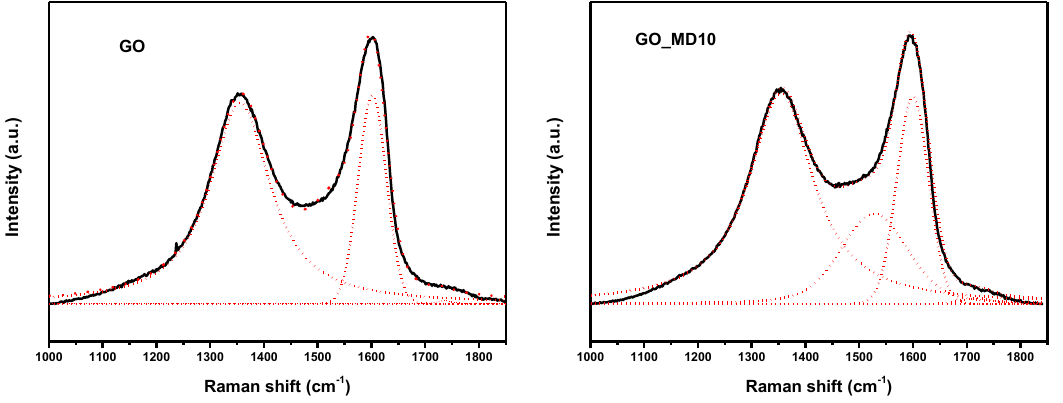
Figure 3. Deconvolution of Raman spectra of GO and GO_MD10 in the range of 1000-1850 cm − 1 .